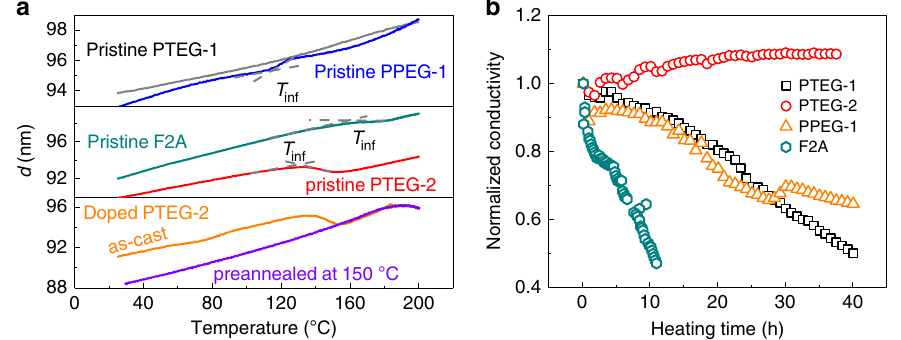
Fig. 2 Thermal response and stability of thin- fi lm samples. a Plots of variable temperature ellipsometry scans for pristine PTEG-1, PTEG-2, and F2A, and doped PTEG-2 fi lms; b evolution of normalized electrical conductivity for various doped fullerene derivatives maintained at a temperature of 150